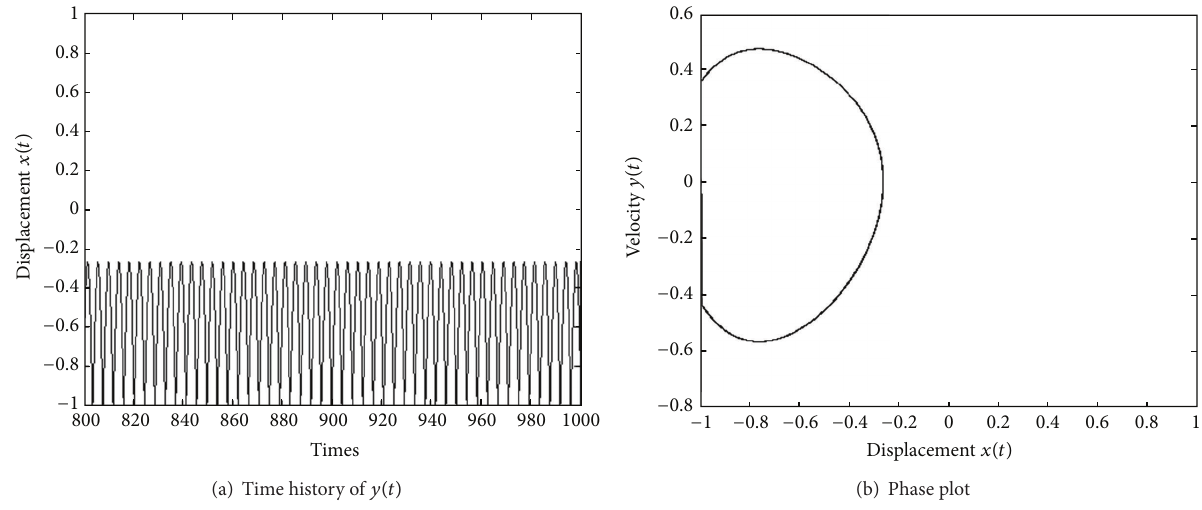
Figure 2: Numerical results of (1) ( 𝑓 1 = 2.5, 𝑓 2 = 0.0, 𝑥(0) = −0.8, ̇𝑥(0) = −2.5